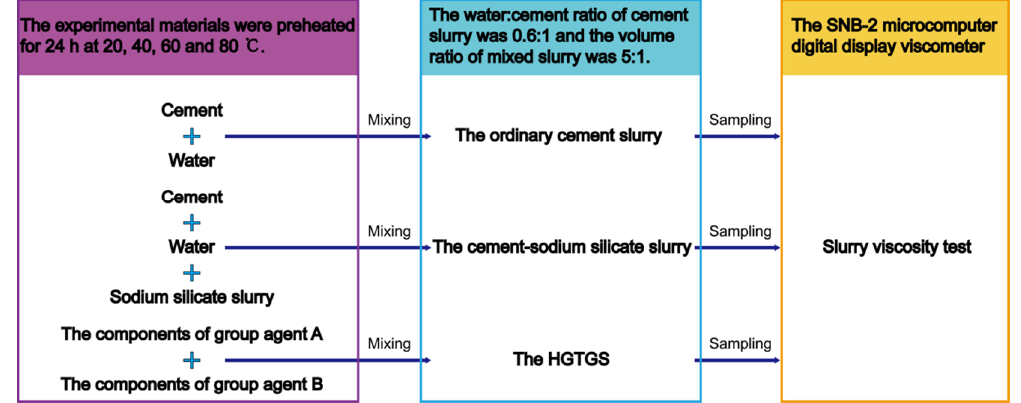
Figure 4. Experimental method.